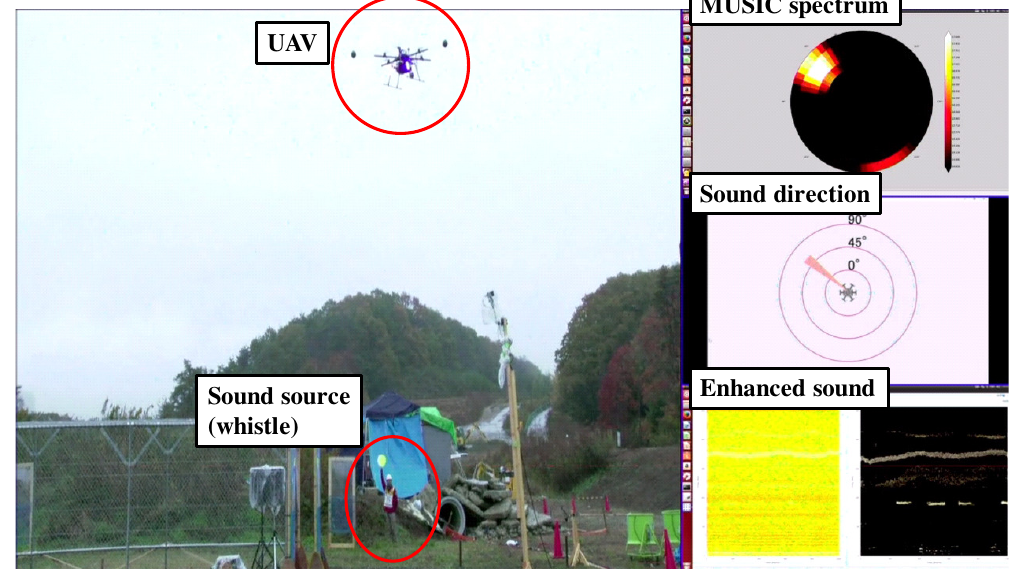
Figure 15. Data visualized in the